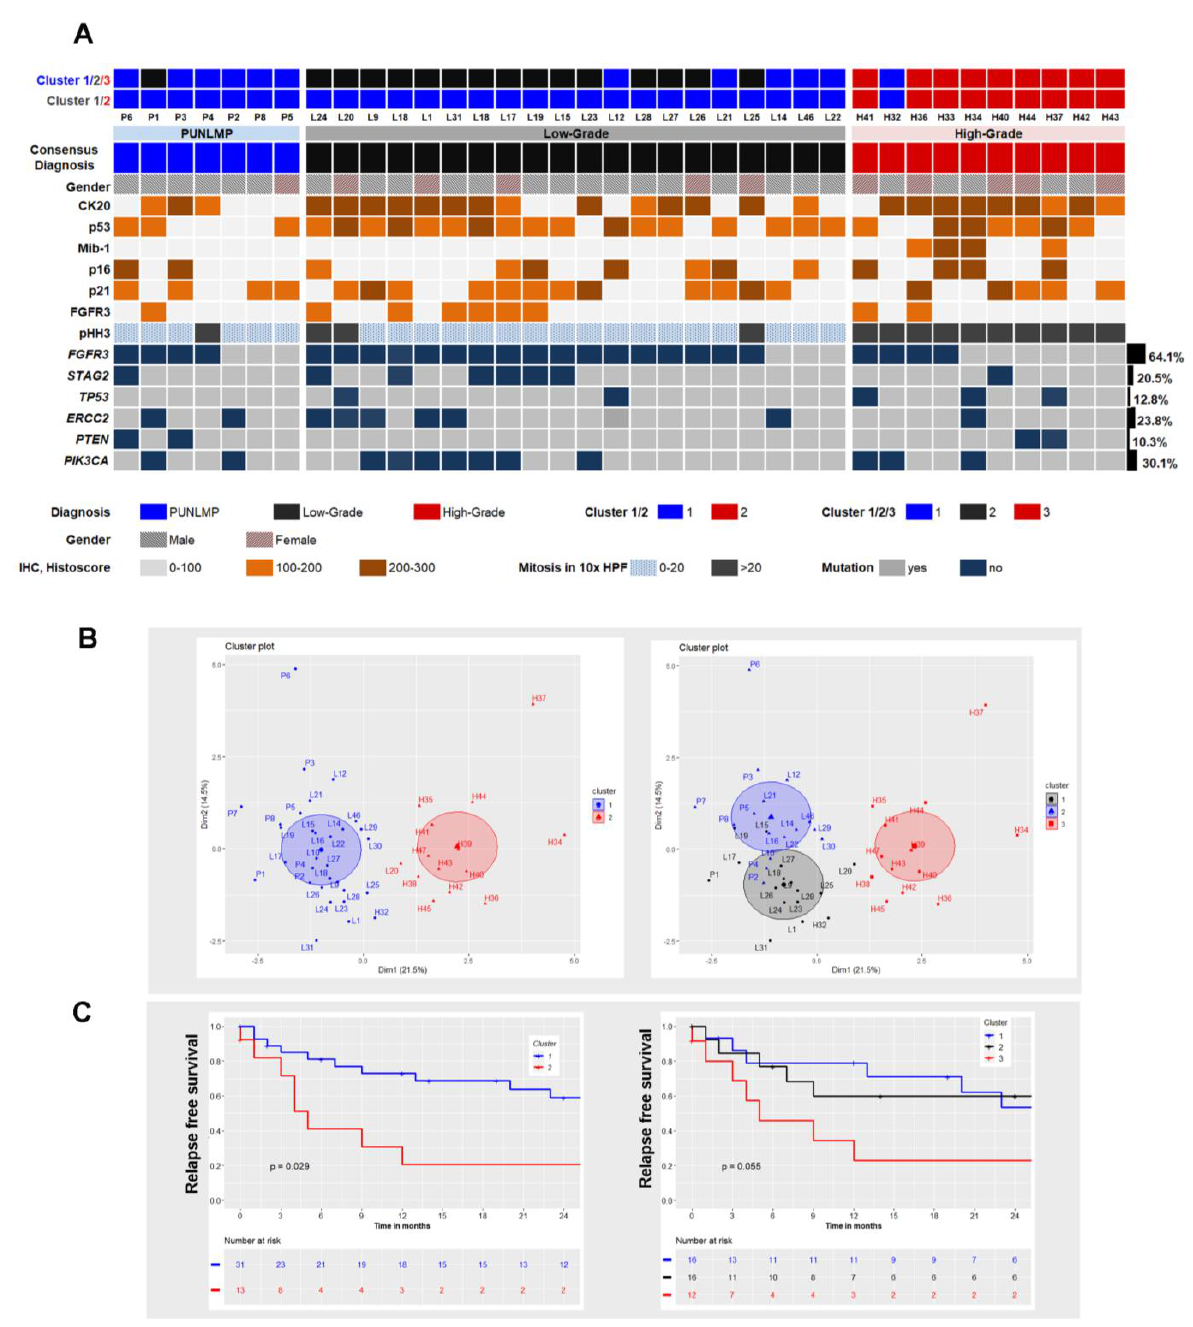
Figure 3. ( A ). Overview of the mutational and immunohistochemical results per diagnostic category. ( B ). Cluster analysis of two and three subgroups (right and left, respectively). ( C ). Kaplan–Meier plots of relapse-free survival using the cluster analysis displayed in cluster plots.